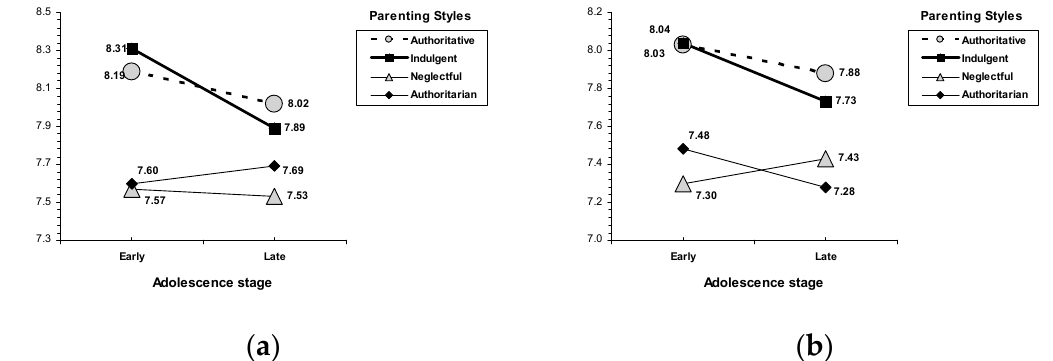
Figure 2. Interactions for parenting style by age. ( a ) universalism, ( b ) security.